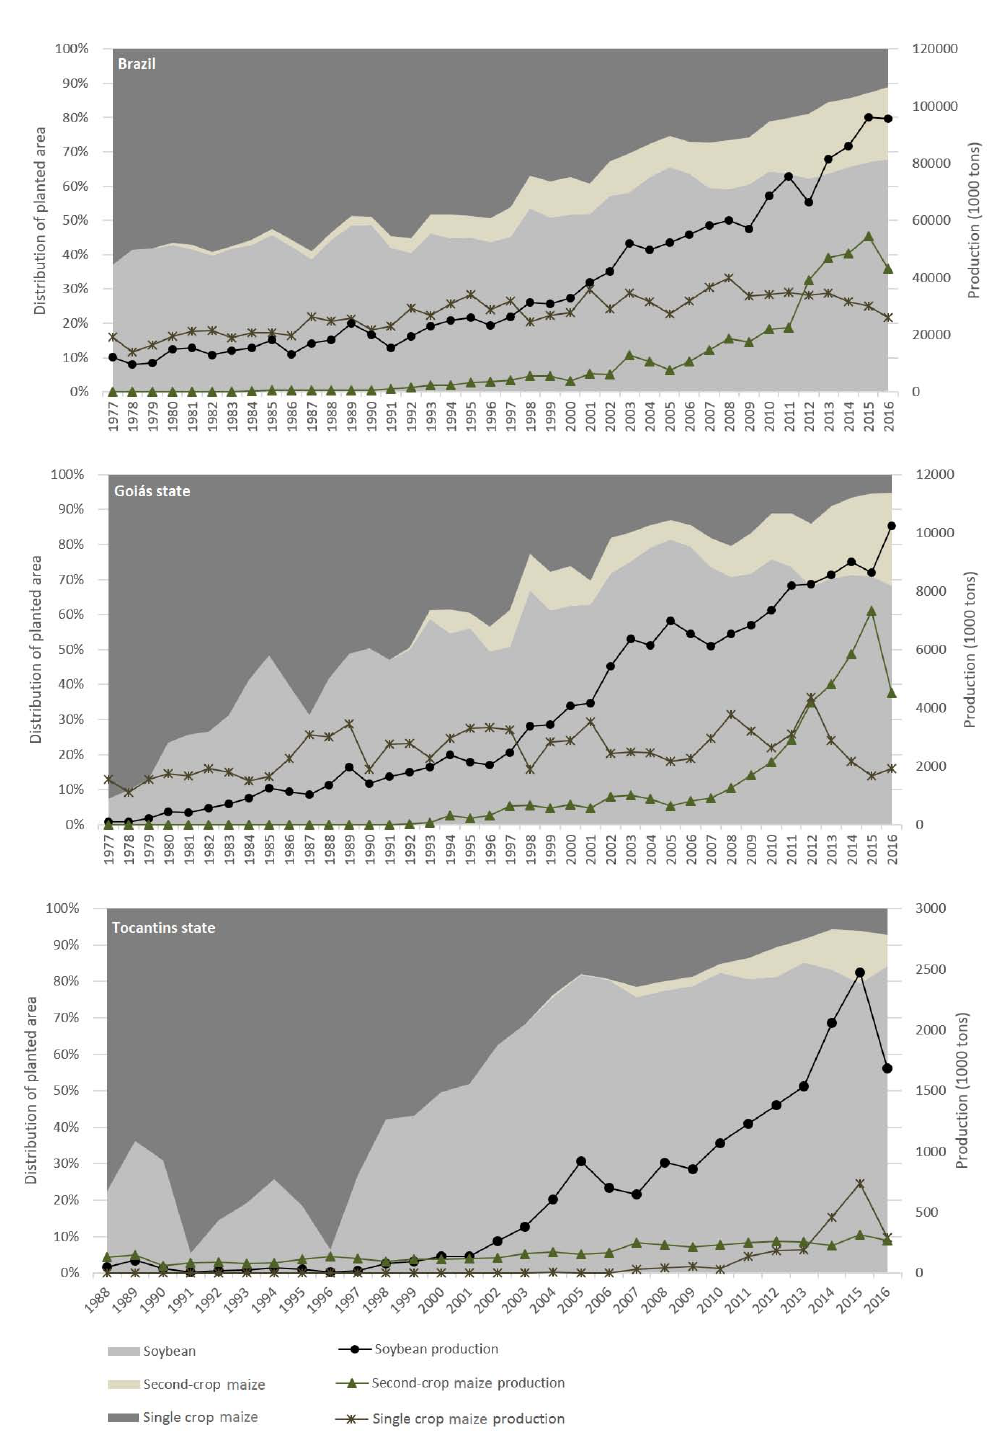
Figure 4. The graphics represent land-use changes from the one-crop system of predominantly maize (maize single crop), to the two-crop system of soybean and maize as the second-crop. The left axis shows the proportion (colored area) and the right axis shows the absolute production (lines) (Conab, Supplementary Material